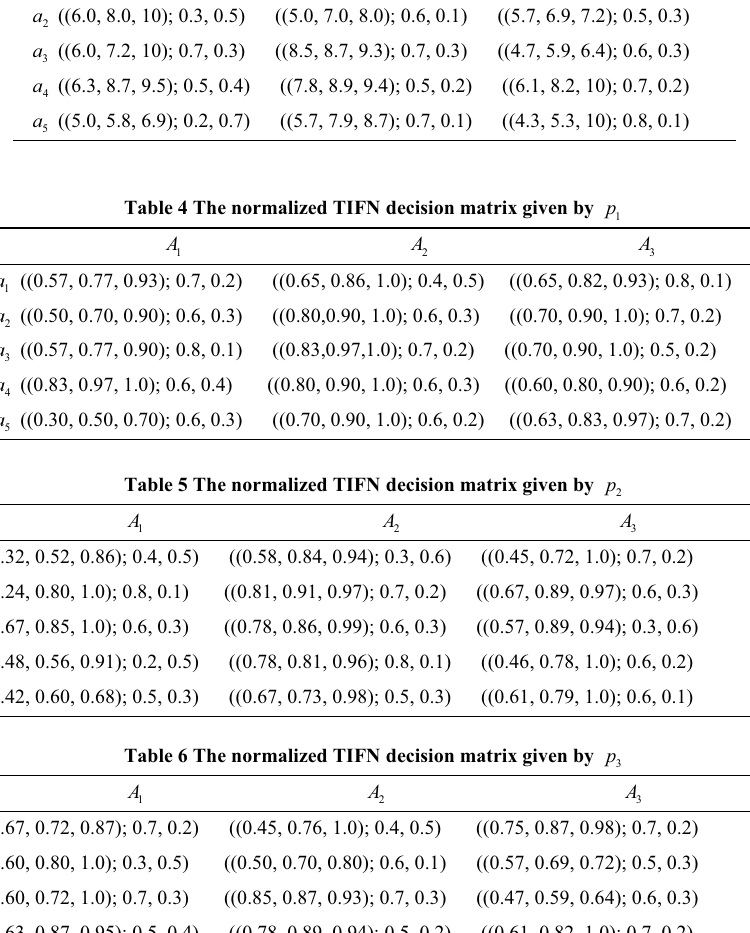
Table 3 The TIFN decision matrix given by